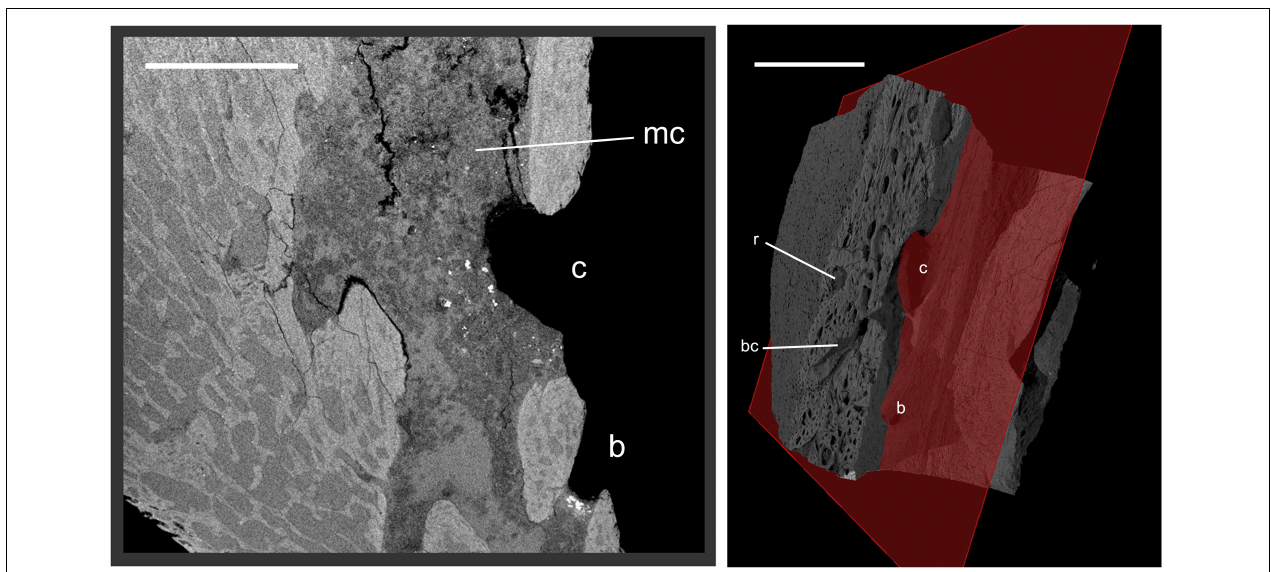
FIGURE 4 | Closeup view in parasagittal section through the premaxilla of YPM 13106. The position of the plane of section is indicated on the right panel (ventro-lateral left view in volume). The regions surrounding the canals (and the cavity with which they communicate), including at openings on the palatal surface (b, c) (see Figure 1 ), show no difference in structure with the rest of the bone. The numerous smallest cavities visible in section and all over the surface (left side of specimen on right panel) are osteocyte lacunae. bc, branched canal; mc, medullary cavity; r, resorption pit corresponding to the site of a possible future secondary osteon. Scale bars, 5